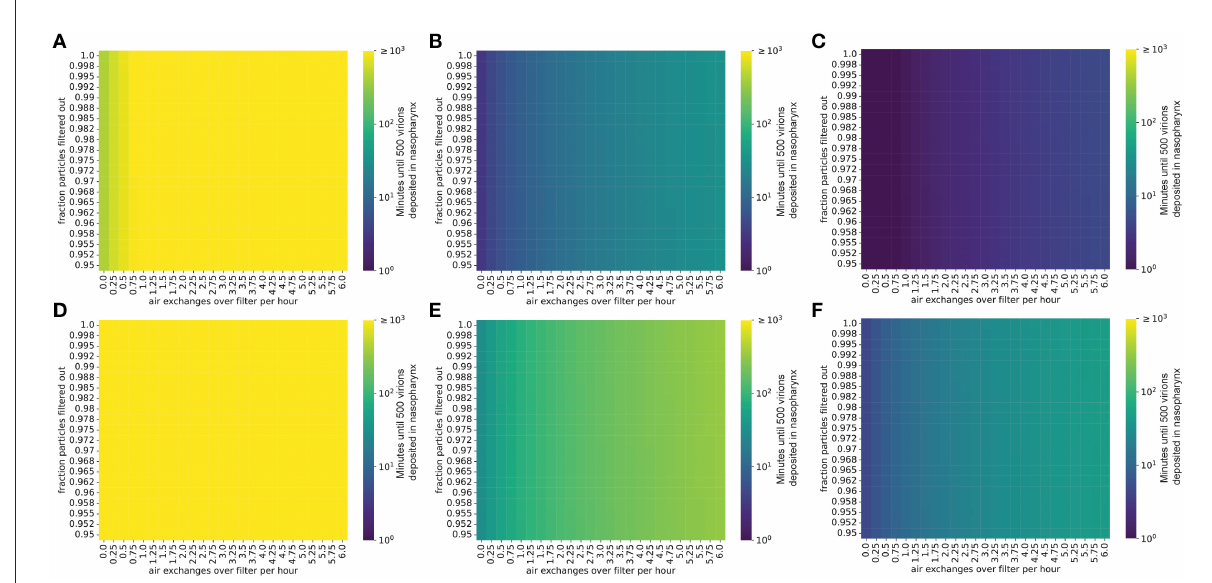
FIGURE5 The presence of robust mitigation measures substantially increases the time to infection for low viral load strains. Plots show the time until an uninfected individual receives 500 virions in a room occupied by an infected individual. (A–C) Individual infected with a low viral load, (A) intermediate viral load, (B) or high viral load, (C) strain, no mask. (D–F) Individual infected with a low viral load, (D) intermediate viral load, (E) or high viral load, (F) strain, with the emitter wearing a 90% effective mask (one-way masking).